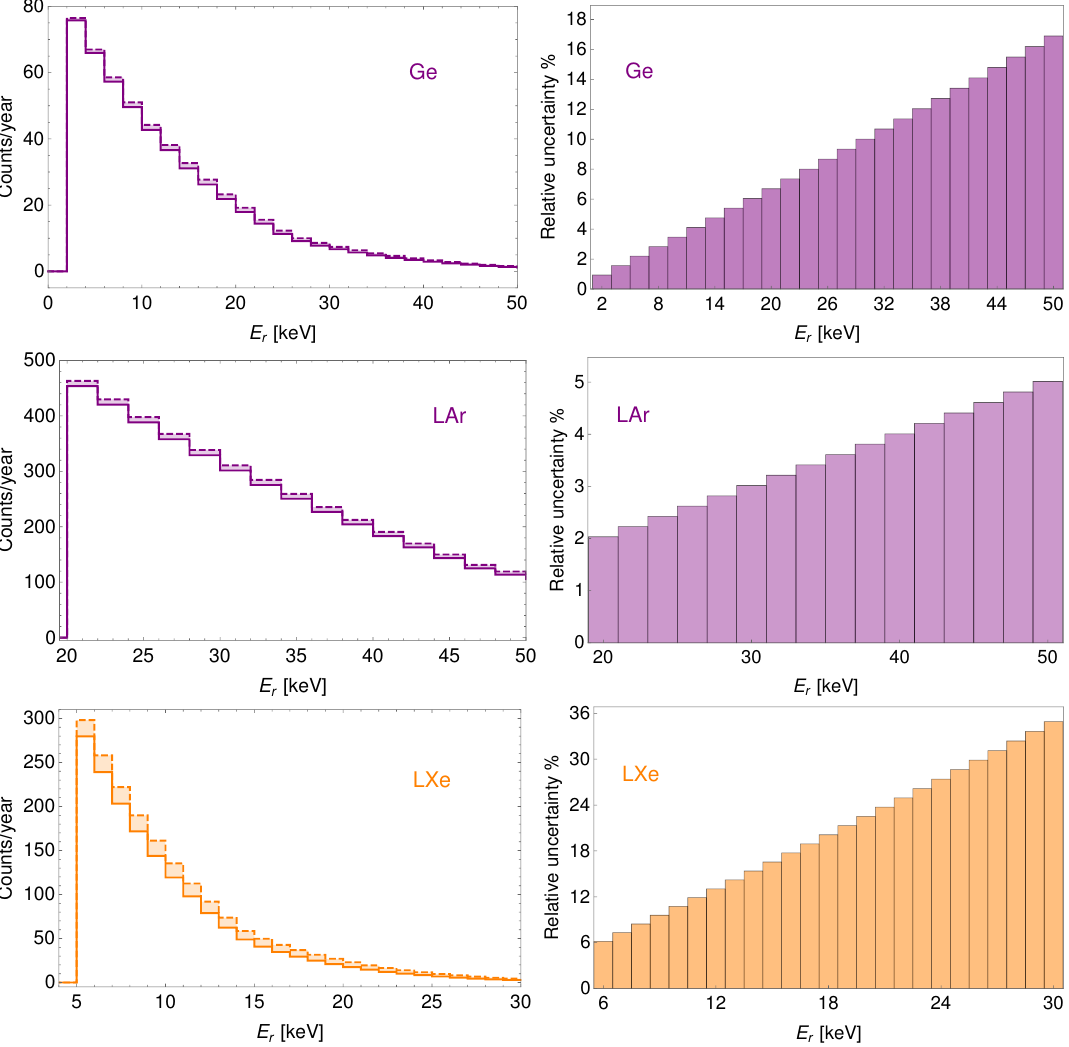
Figure 3 . Expected number of CE (cid:23) NS events ( left ) and its relative uncertainty, equal to (maxi- mum count number-minimum count number) = (maximum count number) (cid:2) 100, ( right ) as a function of recoil energy for argon, germanium and xenon. The calculations have been done for the COHER- ENT Ge, LAr and LXe detectors including form factor uncertainties, summing the three neutrino (cid:13)avor contributions and taking n POT as in the CsI